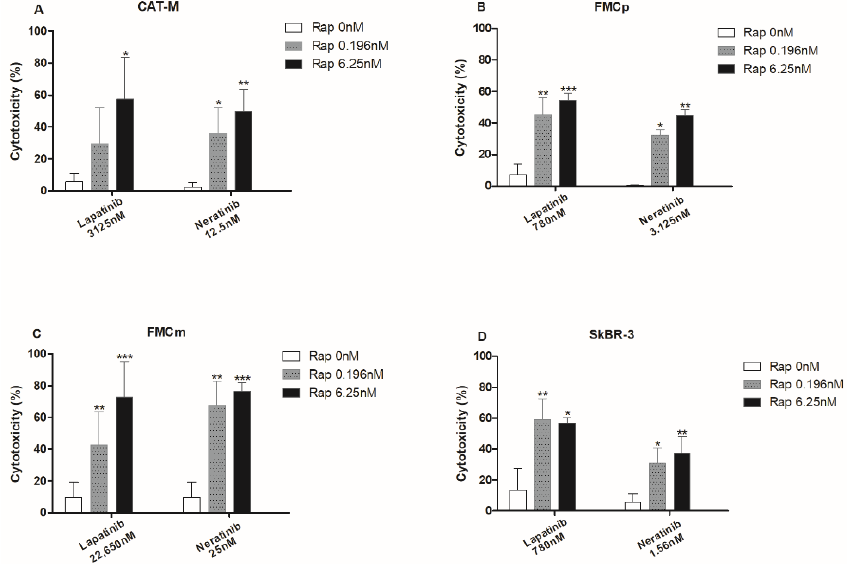
Figure 4. Combinations of TKi and mTOR inhibitor (lapatinib plus rapamycin and neratinib plus rapamycin) showed synergistic antiproliferative effects in feline mammary tumor cell lines. ( A ) CAT-M cells presented a significantly higher antiproliferative response when exposed to lapatinib at 3125 nM plus rapamycin at 6.25 nM or incubated with neratinib at 12.5 nM plus rapamycin at 6.25 nM (57.5% of cytotoxicity, * p < 0.05; 49.9% of cytotoxicity, ** p < 0.01, respectively). ( B ) FMCp cells showed significant synergistic effects of conjugations between lapatinib at 780 nM plus rapamycin at 0.196 nM or at 6.25 nM (45.5% of cytotoxicity, ** p < 0.01; 54.4% of cytotoxicity, *** p < 0.001, respectively), and when neratinib at 3.125 nM plus rapamycin at 0.196 nM or at 6.25 nM were used (32.1% of cytotoxicity, * p < 0.05; 44.5% of cytotoxicity, ** p < 0.01, respectively). ( C ) FMCm cells presented an increased cytotoxic response to the conjugations of lapatinib at 22,650 nM plus rapamycin at 0.196 nM or at 6.25 nM (42.6% of cytotoxicity, ** p < 0.01; 95.2% of cytotoxicity, *** p < 0.001, respectively) and neratinib at 25 nM plus rapamycin at 0.196 nM or at 6.25 nM (67.7% of cytotoxicity, ** p < 0.01; 76.3% of cytotoxicity, *** p < 0.001, respectively). ( D ) SkBR-3 cells used as control, displayed similar antiproliferative responses to feline cell lines. All the assays were performed in triplicate and repeated a total of three separated times.